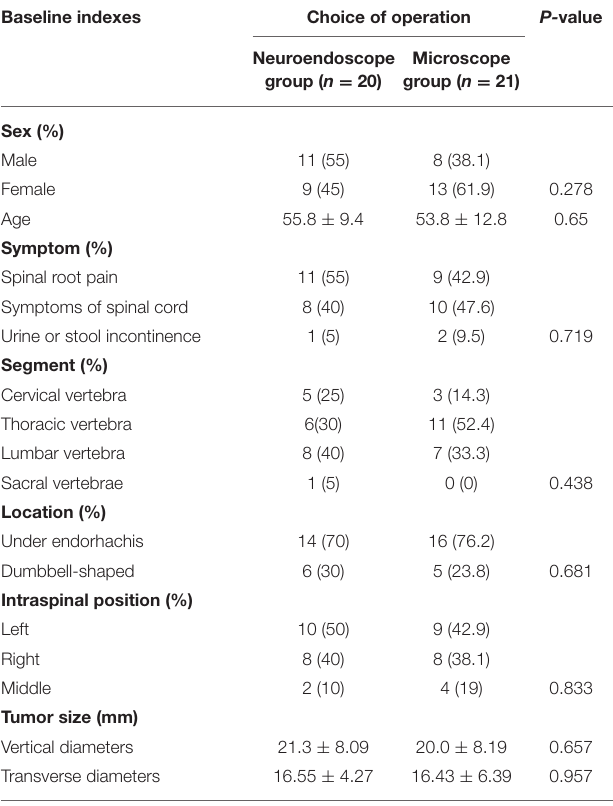
TABLE 1 | Baseline indices in the UHMV and UHNV